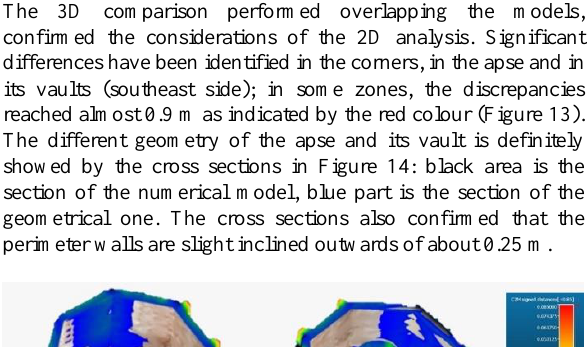
Figure 15. Static analysis of the current/numerical model (left) and the historical/geometrical model (right)